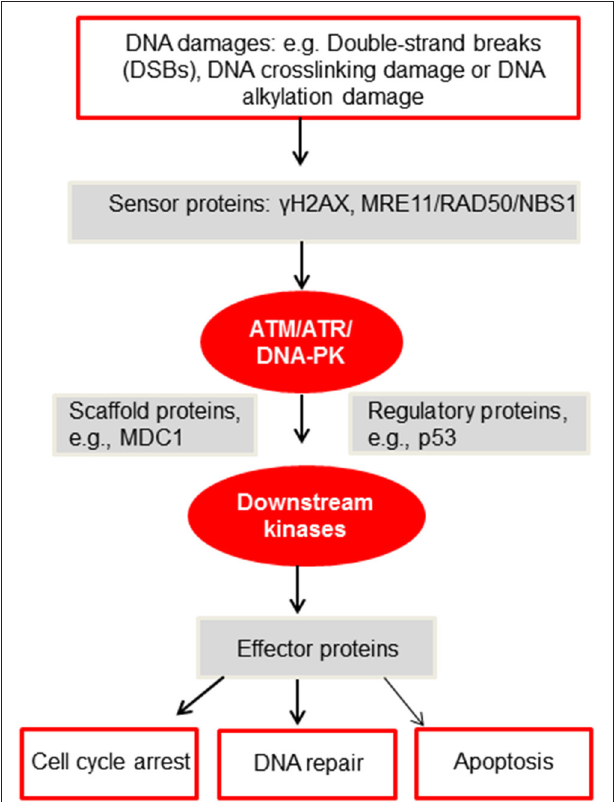
FIGURE 2 | A simplified diagram of the DDR network adapted from Furgason and Bahassi (94). When genomic DNA is faced with various DNA damages, such as but not limited to DSBs, DNA crosslinking damage or alkylation damage, sensor proteins such as γ H2AX and the MRE11/RAD50/NBS1 (MRN) complex will then recruit and activate the PIKK kinases, including ATM, ATR and DNA-PK. These PIKK kinases will then phosphorylate downstream targets, including scaffold proteins, regulatory proteins and downstream kinases. Upon activation, these proteins will subsequently phosphorylate effector proteins to undergo cell cycle arrest, DNA repair or apoptosis. For a detailed mechanistic analysis of the DDR, please refer to Ciccia and Elledge